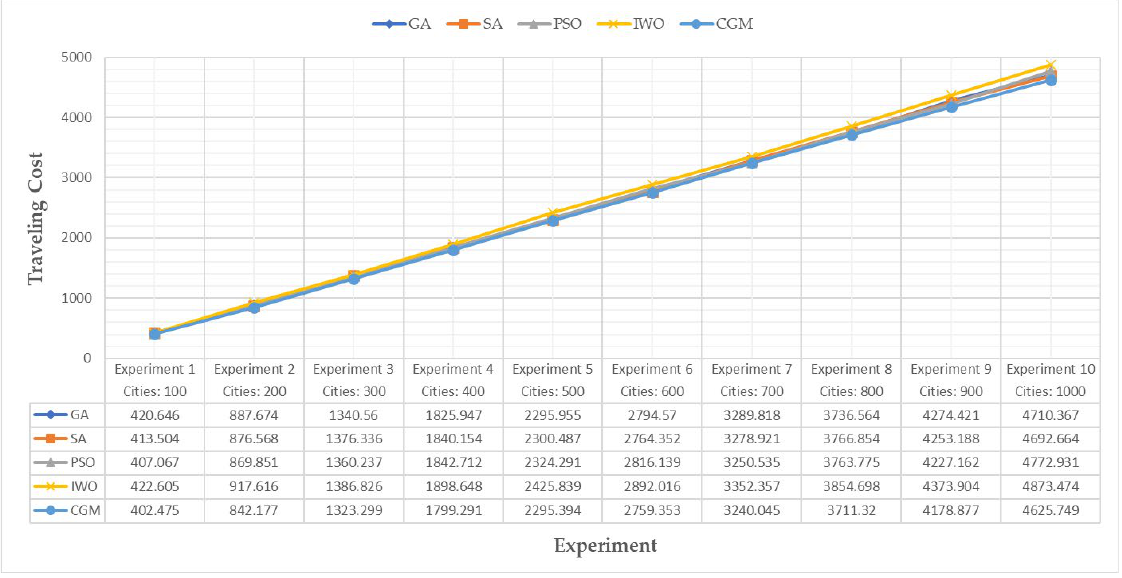
Figure 14. Scalability of the CGM mechanism for the traveling salesman problem compared with other algorithms.